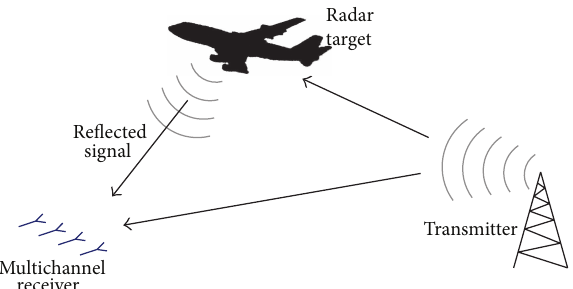
Figure 1: Signals transmitted from sources of opportunity are used asilluminationtodetectradartargets.Typicalradarparameterssuch as direction, range, or velocity may be derived from the comparison between the direct line-of-sight (LoS) signal from the transmitter and the signal scattered from the target